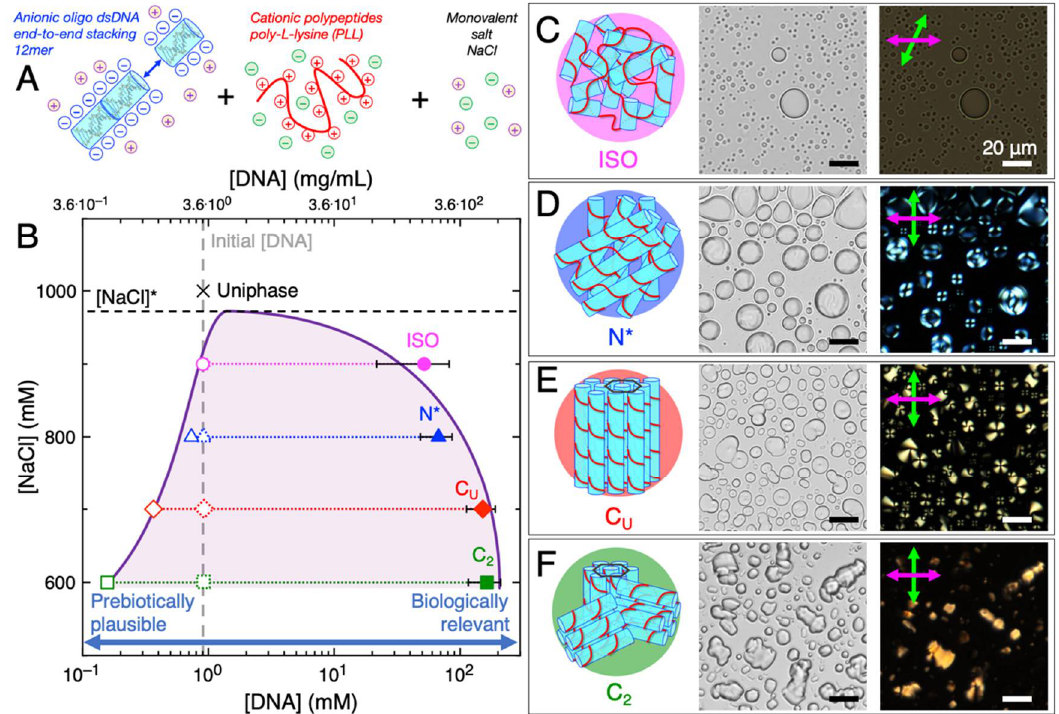
Figure 1. Liquid crystal (LC)-coacervate phase diagram and structure as function of [NaCl]. ( A ) Mixing of an anionic s-dsDNA 12-mer (reverse Dickerson dodecamer (rDD), 5′-GCGCTTAAGCGC-3′) capable of end-to-end stacking with a 240-residue cationic peptide (poly-L-lysine, PLL) in the presence of a monovalent salt (sodium chloride, NaCl) resulted in assembly of LC-coacervates. ( B ) Phase diagram of mixtures of rDD and PLL (N = P = 10 mM) as a function of [DNA] and [NaCl]. The initial preparation (DNA = 0.91 mM ~ 3.3 mg/mL) is identified by the vertical grey dashed line and dashed open symbols. Below a critical salt concentration, [NaCl]* (horizontal black dashed line), the system de-mixes in a dense coacervate phase (filled symbols) coexisting with a diluted liquid phase (open symbols). The dense inner coacervate phase shows different degrees of order as function of [NaCl]: isotropic (ISO) at 900 mM NaCl (magenta circle), cholesteric (N*) at 800 mM NaCl (blue triangle), uniaxial columnar (C U ) at 700 mM NaCl (red diamond), and higher-order columnar (C 2 ) at 600 mM NaCl (green square). At 1 M NaCl, the system existed as a uniform phase (black cross). The measured DNA concentration ( Methods ) testifies a ~100/1000-fold DNA enrichment in the dense coacervate phase. Error bars indicate standard mean error. A qualitative binodal line (solid purple line), dividing the diagram in a two-phase-region (purple shading) and a uniphase region (white), was drawn by interpolating the datapoints with a spline. Hypothetical tie lines (horizontal dotted lines) have also been reported. Coacervation is shown to enrich [DNA] from prebiotically plausible regimes to LC enabling and biologically relevant regimes. ( C – F ) Sketches of the inner structure and optical microscopy images of the observed coacervates phases: ISO characterized by optically inactive droplets of disordered liquid DNA-PLL complexes ( C ), N* characterized by typical fingerprint textures formed by twisted nematic planes of DNA-PLL complexes ( D ), C U characterized by focal conic structures formed by bending-prone two-dimensional hexagonally ordered DNA-PLL complexes ( E ), and C 2 characterized by more uniform and sharp-edged birefringent domains given by tight hexagonal order of DNA-PLL complexes where bending is suppressed ( F ). Middle: brightfield transmission optical microscope (BFTOM) image. Right: polarized transmission optical microscopy (PTOM) image. Scale bars are 20 µm.